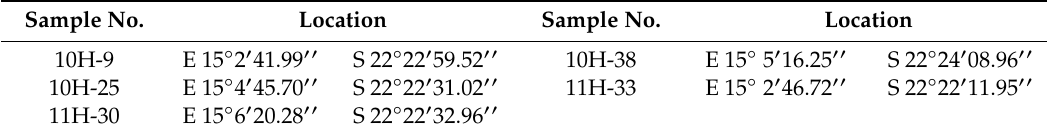
Table 1. Sampling location of biotite granites in the Gaudeanmus